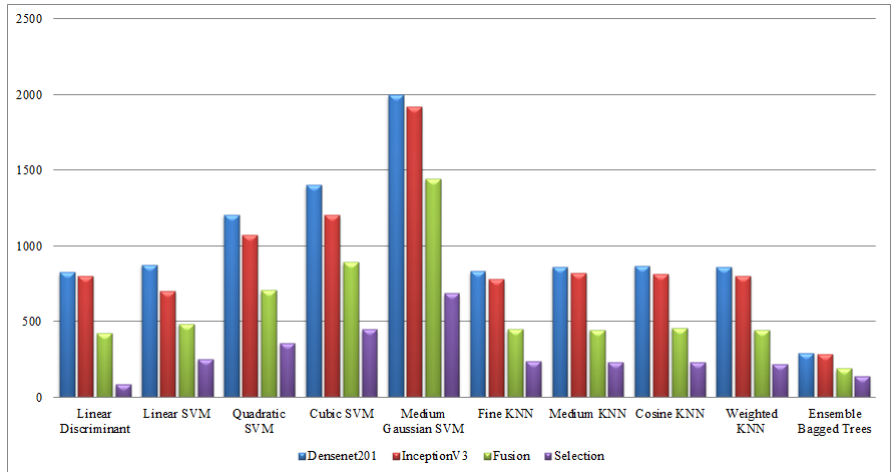
Figure 16. Computational time-based comparison of middle steps on KTH dataset.